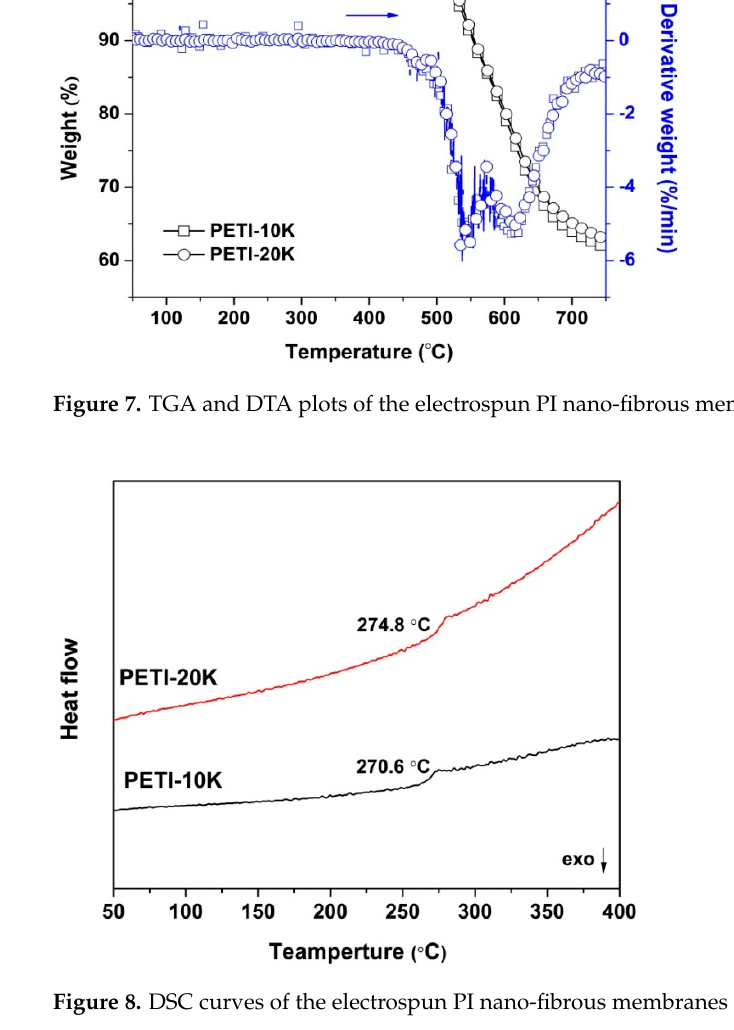
molecular chains of the polymers. The T g values of PI NFMs were 270.6 °C for PETI ‐ 10K and 274.8 °C for PETI ‐ 20K, respectively. PETI ‐ 20K NFM with relatively higher molecular